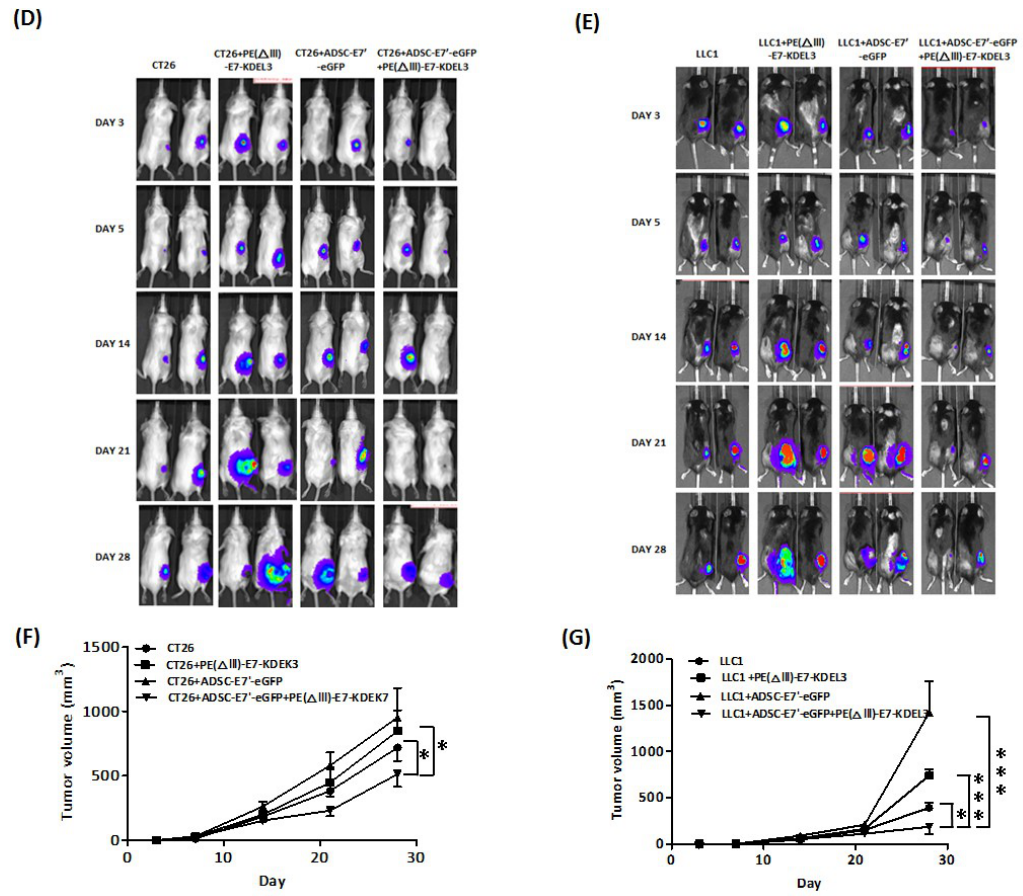
Figure 3. The tumor inhibition of the combined treatment by the systemic administration of ADSC-E7’-eGFP and the protein vaccine. The GFP immunohistochemical staining of ( A ) the CT26 tumor with or without the systemic administration of ADSC-E7’-eGFP cells; or ( B ) the LLC1 tumor with or without the systemic administration of ADSC-E7’-eGFP cells. ( C ) Time course of the experiment. Two representative bioluminescence images of mice subcutaneously injected with ( D ) 2 × 10 5 CT26 cells with indicated treatment; or ( E ) 2 × 10 5 LLC1 cells with indicated treatment. Tumor volume measurements of syngeneic tumor models were conducted at indicated days after subcutaneous injection of ( F ) CT26 cells; or ( G ) LLC1 cells; * p < 0.05, ** p < 0.01; and *** p < 0.001 using two-way ANOVA.